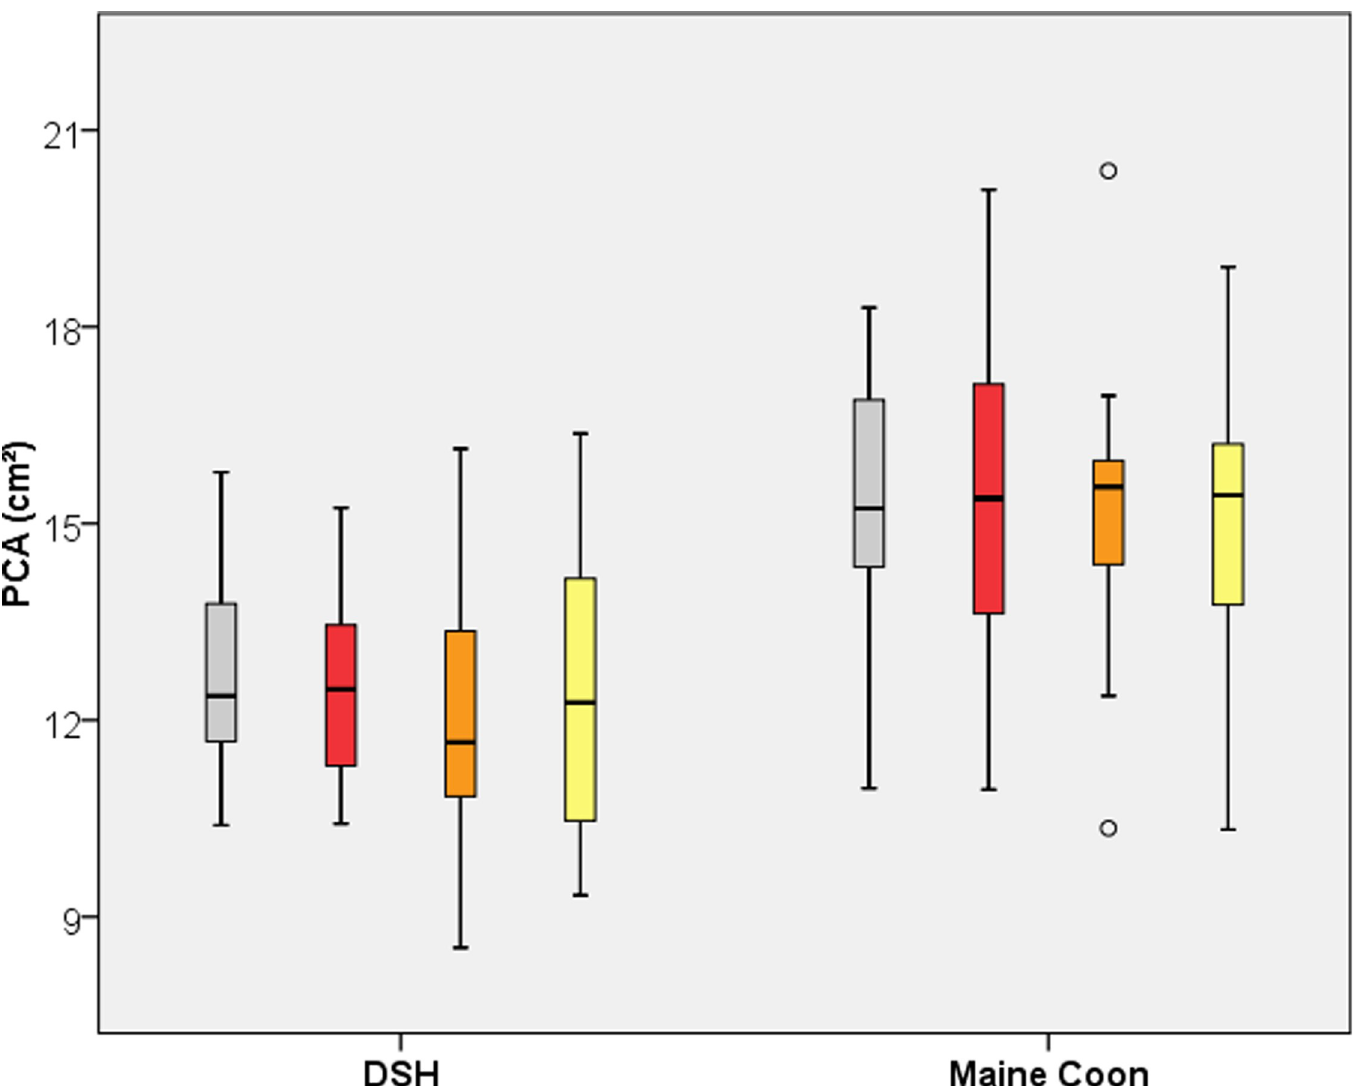
Fig 1. Boxplot of the Paw Contact Area (PCA) for Domestic Shorthair and Maine Coon Cats. Grey = left forelimb; red = right forelimb; orange = left hind limb; yellow = right hind limb.